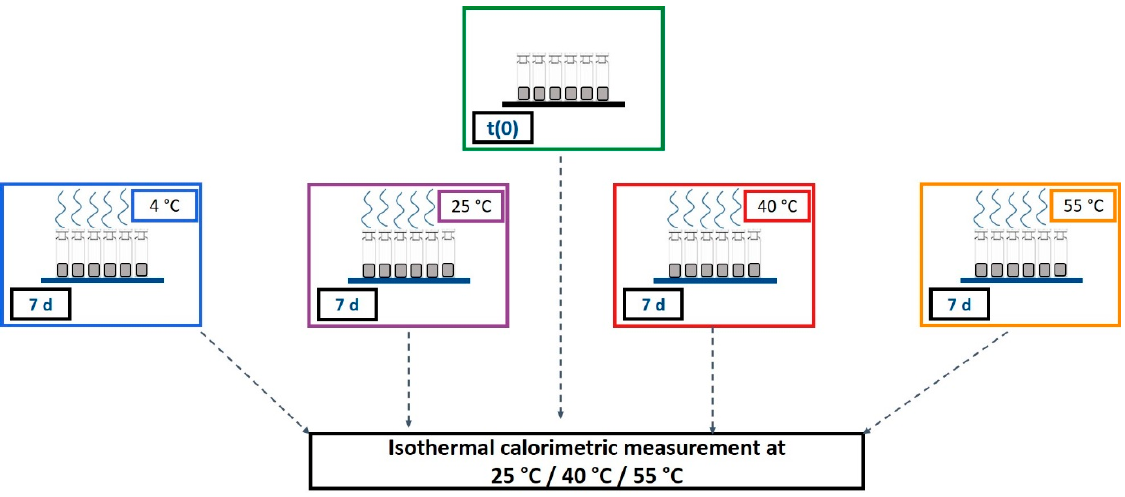
Figure 6. Overview on the tempering time and temperatures as well as the measurement temperatures in IMC that were used in this study.